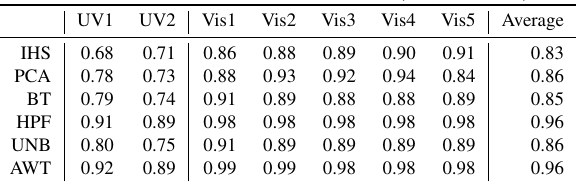
Spectral angle values were computed at each pixel for the five